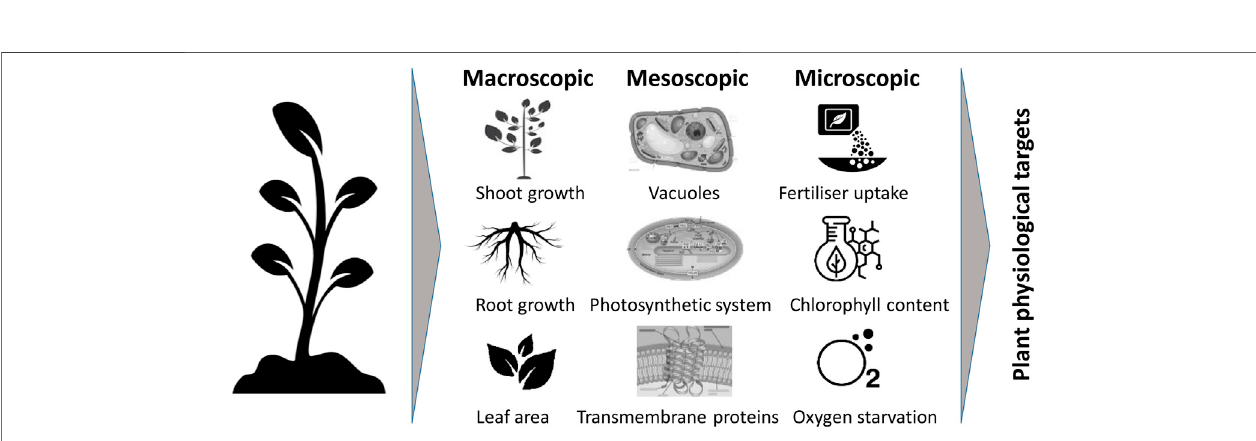
FIGURE 12 | Macroscopic, mesoscopic and microscopic classi fi cation of changes of plants when exposed to various kinds of plant stressors.